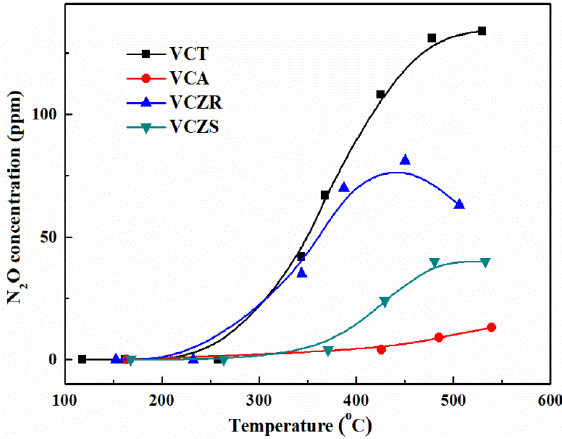
Figure 9. N 2 O concentration with reaction temperature over different samples (reaction conditions: NO = NH 3 = 700 ppm, O 2 = 3%, balance N 2 , 0.5 g catalyst, and GHSV about 50,000 h − 1 ).